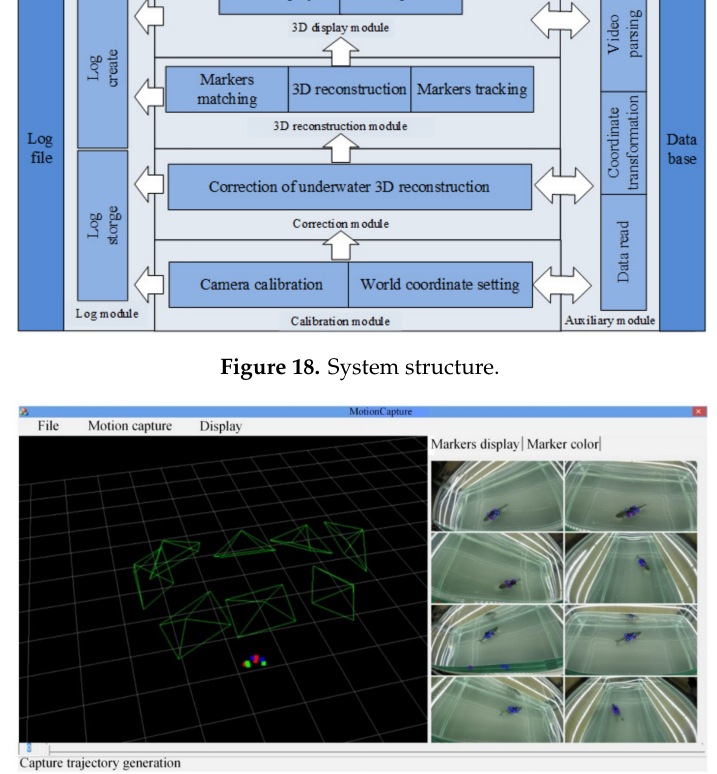
Figure 19. Software